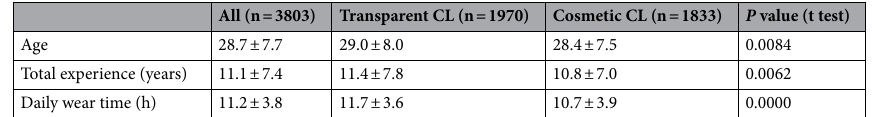
Table 1. Characteristic of studied population by lens type (continuous variables). Mean ± SD; CL, contact